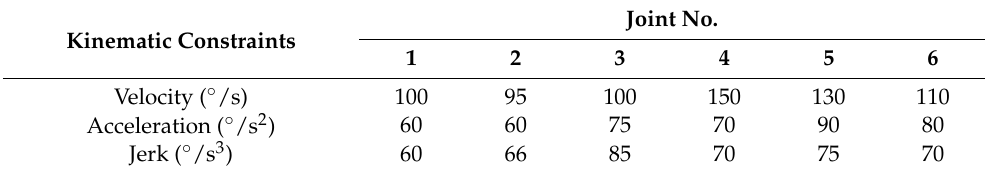
Table 8. Kinematic constraints of the test trajectory planning task.